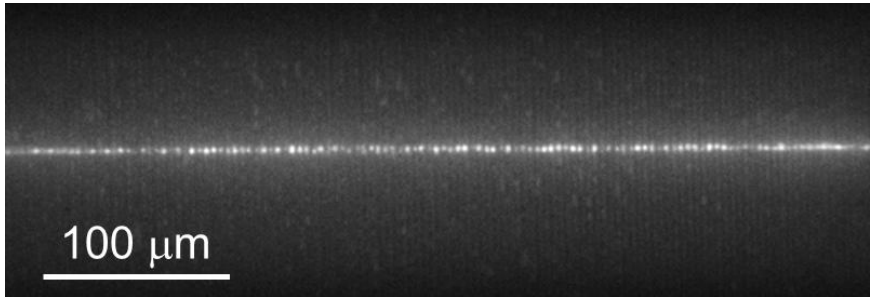
Figure 4. Laser line focused in fluid-filled microchannels. The slit is wide